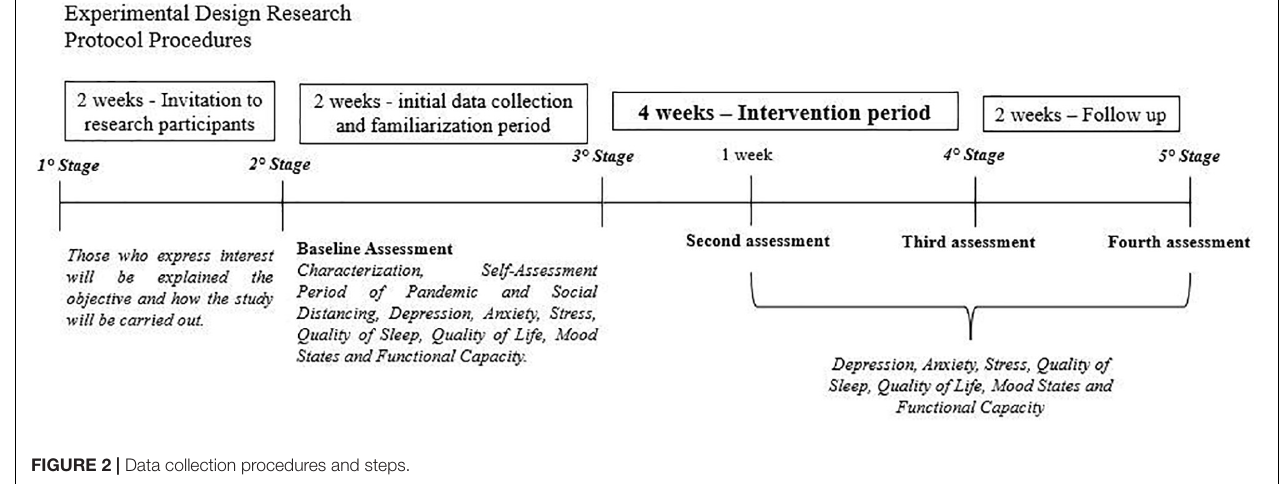
FIGURE 2 | Data collection procedures and steps. TABLE 2 | Home physical exercise protocol for older adults during the COVID-19 pandemic. Intervention Weekly Intensity Volume* Number of series Speed in concentric weeks frequency